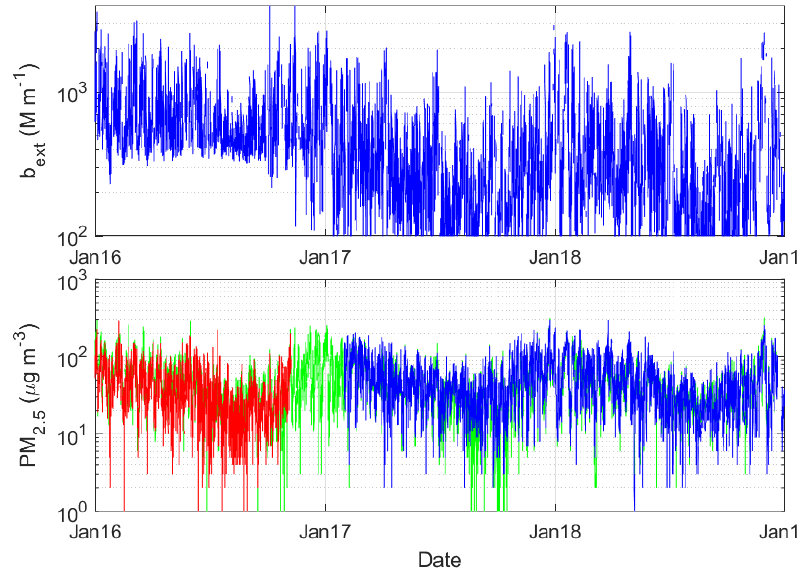
Figure 6. Time series of b ext ( upper ) at Yangzhou, Jiangsu Province, and PM 2.5 ( bottom ) in three adjacent